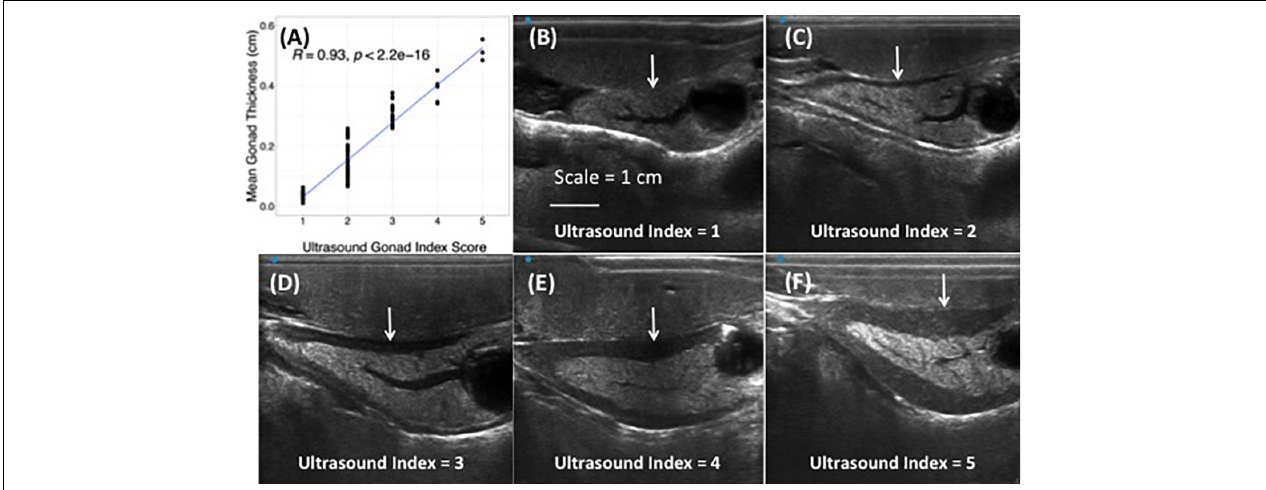
FIGURE 3 | Correlation between quantitative mean gonadal thickness and qualitative ultrasound gonad index scores in cultured red abalone ( Haliotis rufescens ) (A) . Ultrasound visual index classification: (B) index = 1, (C) index = 2, (D) index = 3, (E) index = 4, (F) index = 5. Scale = 1 cm. White arrows indicate progressive thickening of abalone